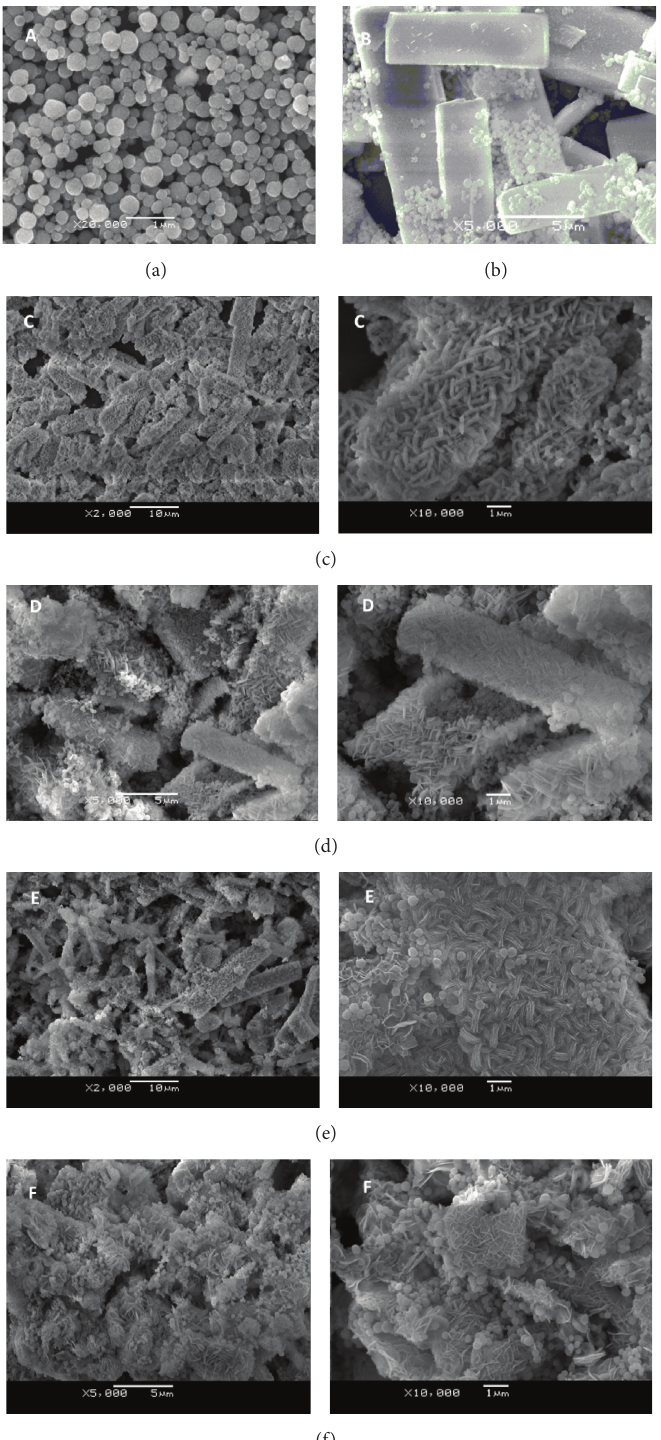
Figure 1: SEM images of samples ((a) Fe 3 O 4 @SiO 2 , (b) BSO-0, (c) BSO-0.05, (d) BSO-0.1, (e) BSO-0.2, and (f)